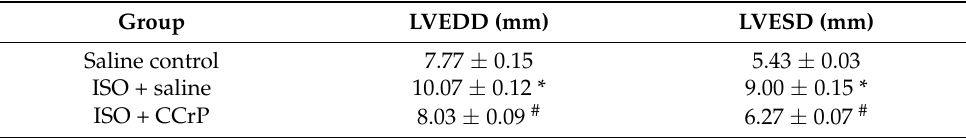
Table 2. After 14 days, ISO/CCrP rats showed normal LVEDD and LVESD, while ISO/saline rats showed a significant increase. * p < 0.05 for ISO/saline vs. saline/control rats, and # p < 0.05 for ISO/CCrP vs. ISO/saline rats.